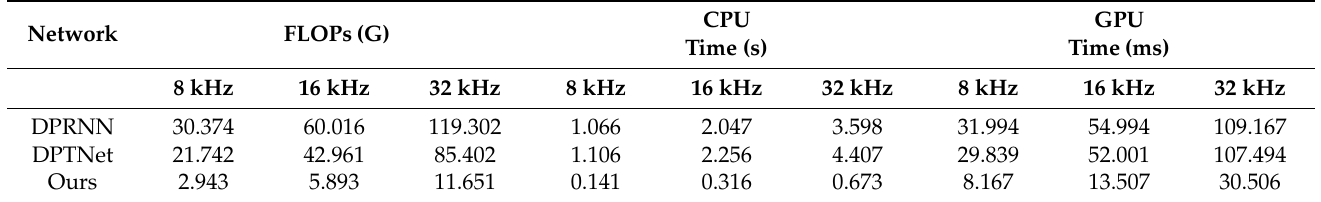
Table 3. Floating point operations and runtimes of different networks for inputting bird sounds with different sampling frequencies.